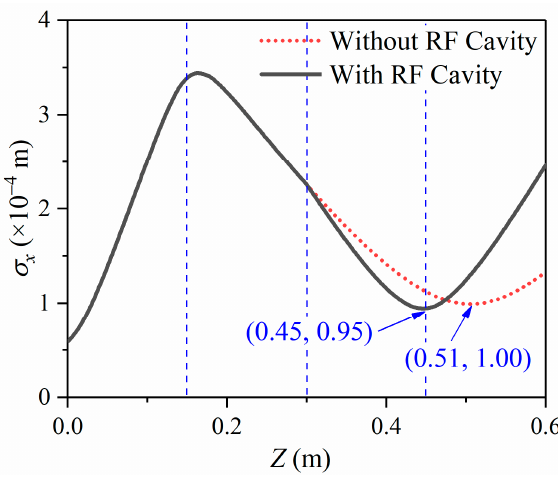
Figure 4. RMS radius 𝜎 (cid:3051) evolves during propagation with the RF cavity or not.